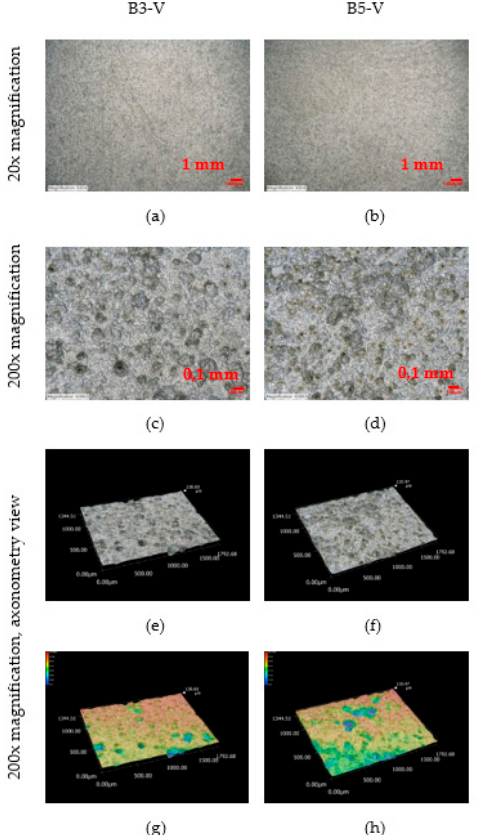
Figure 19. ( a–h ) Structure of the steel surfaces under the corrosion layer—vertical exposure.